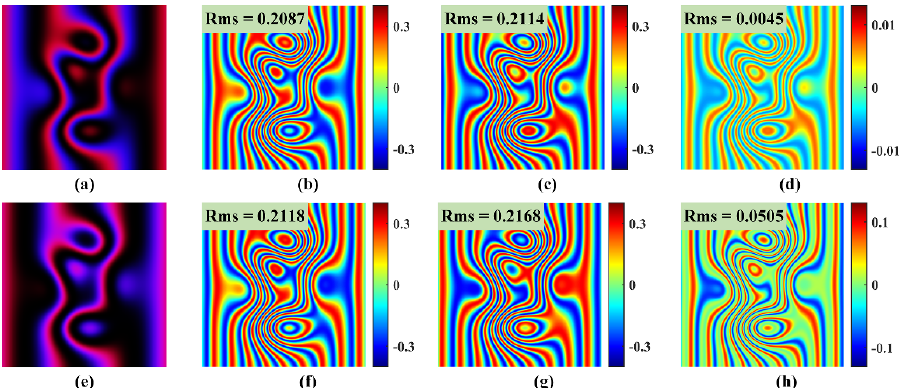
Figure 4. Comparison results when considering color crosstalk. ( a ) Color fringe generated by the proposed IDTP algorithm, and the corresponding phase errors of ( b ) the red channel, ( c ) the blue channel, and ( d ) the average fringe, respectively. ( e ) Color fringe generated by the conventional PDTP algorithm, and the corresponding phase errors of ( f ) the red channel, ( g ) the blue channel, and ( h ) the average phase, respectively.